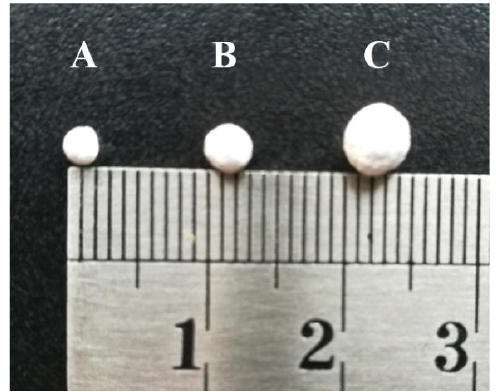
Figure 8. Images of typical polyethylene particles synthesized within 10–30 min (Polymerization time: ( A ) 10 min, ( B ) 20 min, ( C ) 30 min). Reprinted with permission from Ref. [125]. Copyright 2020 Elsevier B.V.